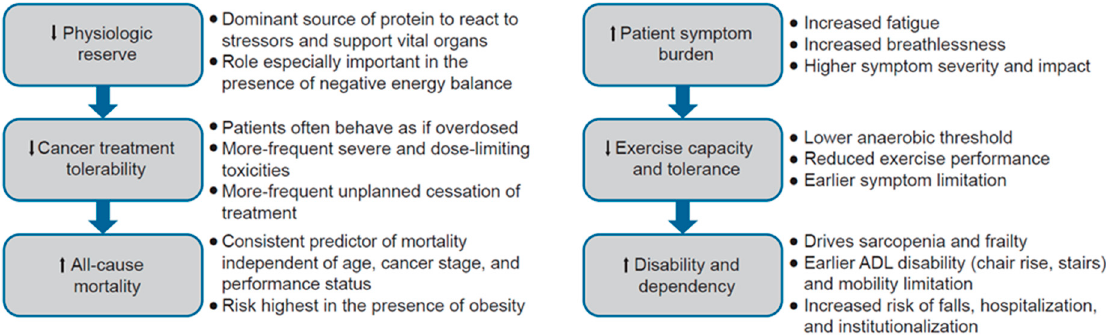
Figure 1. Clinical relevance of low LBM. ADL, activities of daily living; LBM, lean body mass.